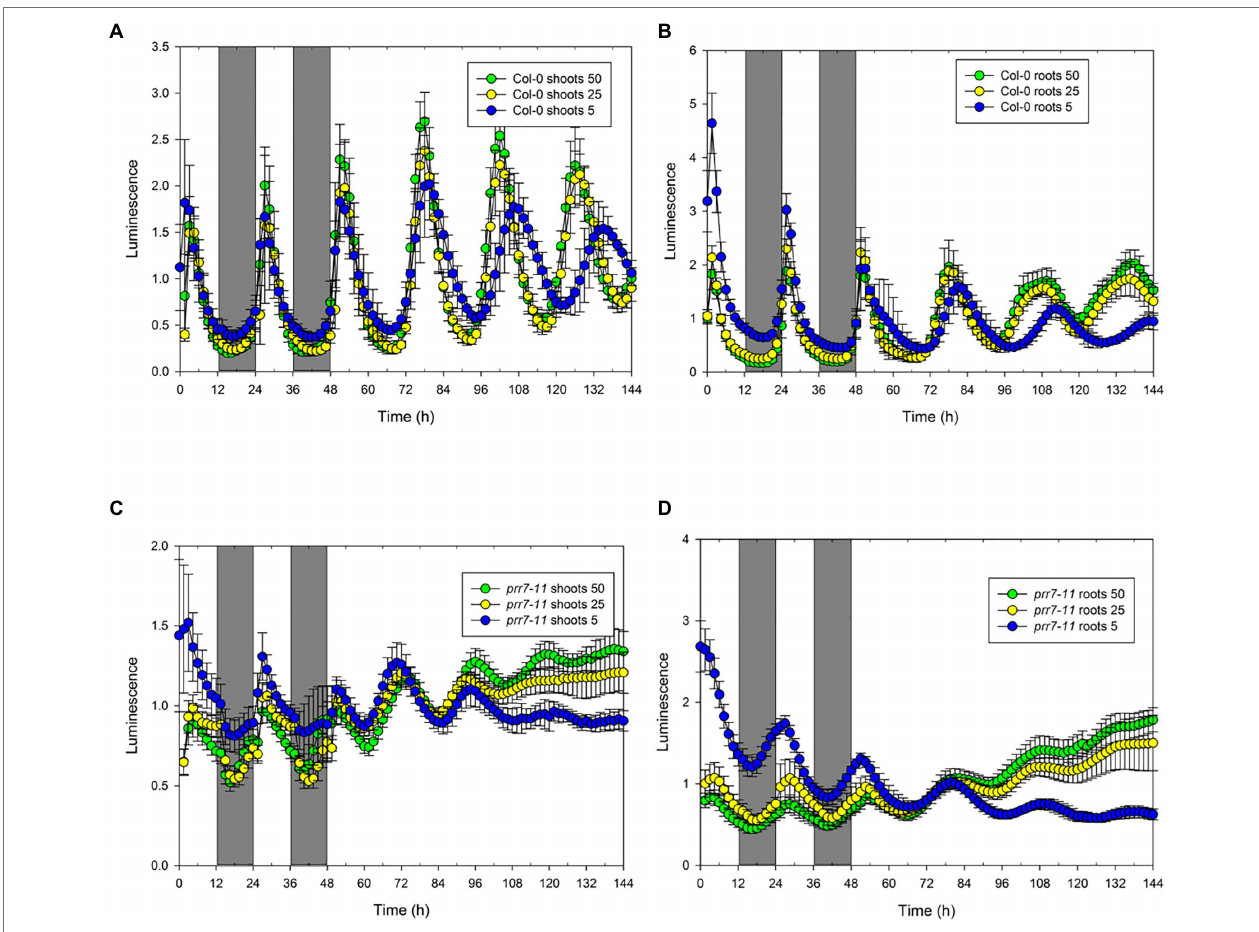
FIGURE 3 | Effect of light intensity on rhythmic behaviour of Col-0 and prr7-11 . The data show mean ± SD luminescence for Col-0 ( n = 14; A,B ) and prr7-11 ( n = 18: C,D ) shoots (A,C) and roots (B,D) expressing CCA1::LUC in two LD cycles followed by 96 h in LL at the indicated light intensities in μ mol/m 2